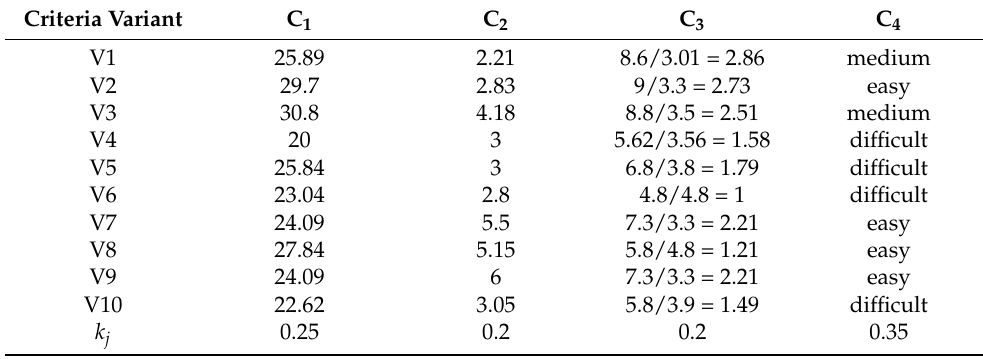
Table 4. Matrix of consequences.